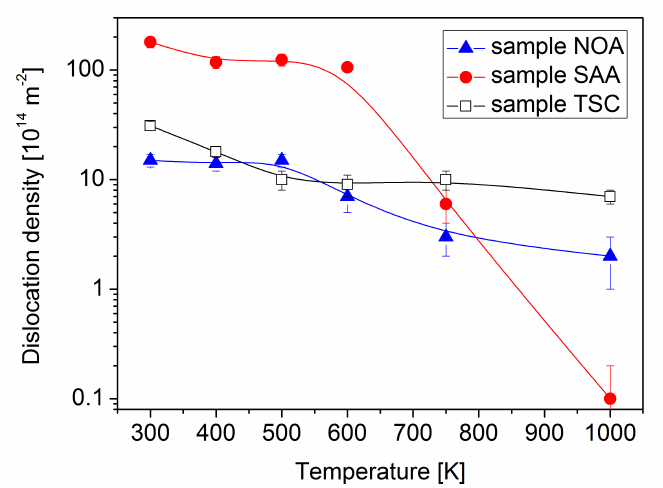
Figure 1. The dislocation density in logarithmic scale obtained by X-ray line profile analysis (XLPA) versus the heat treatment temperature. The curves are only for guidance and do not represent any fitting model.